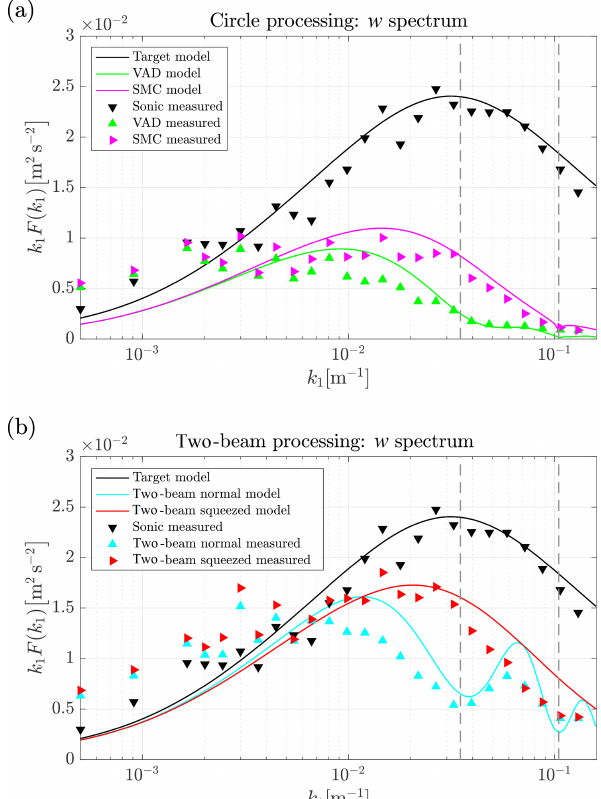
Figure 7. Modeled (solid lines) and measured (triangle markers) w spectra from data processing for which (a) all radial measurements are used and (b) only two beams are used. Colors correspond to processing method. The grey vertical dashed lines represent the first and second resonance wave